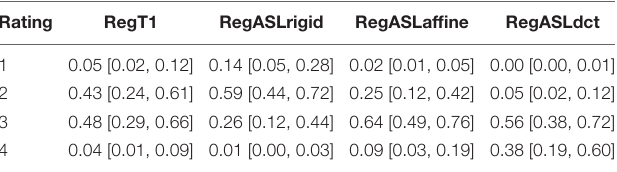
TABLE 3 | Estimated probability of getting a particular rating for each type of registration (and corresponding 95%